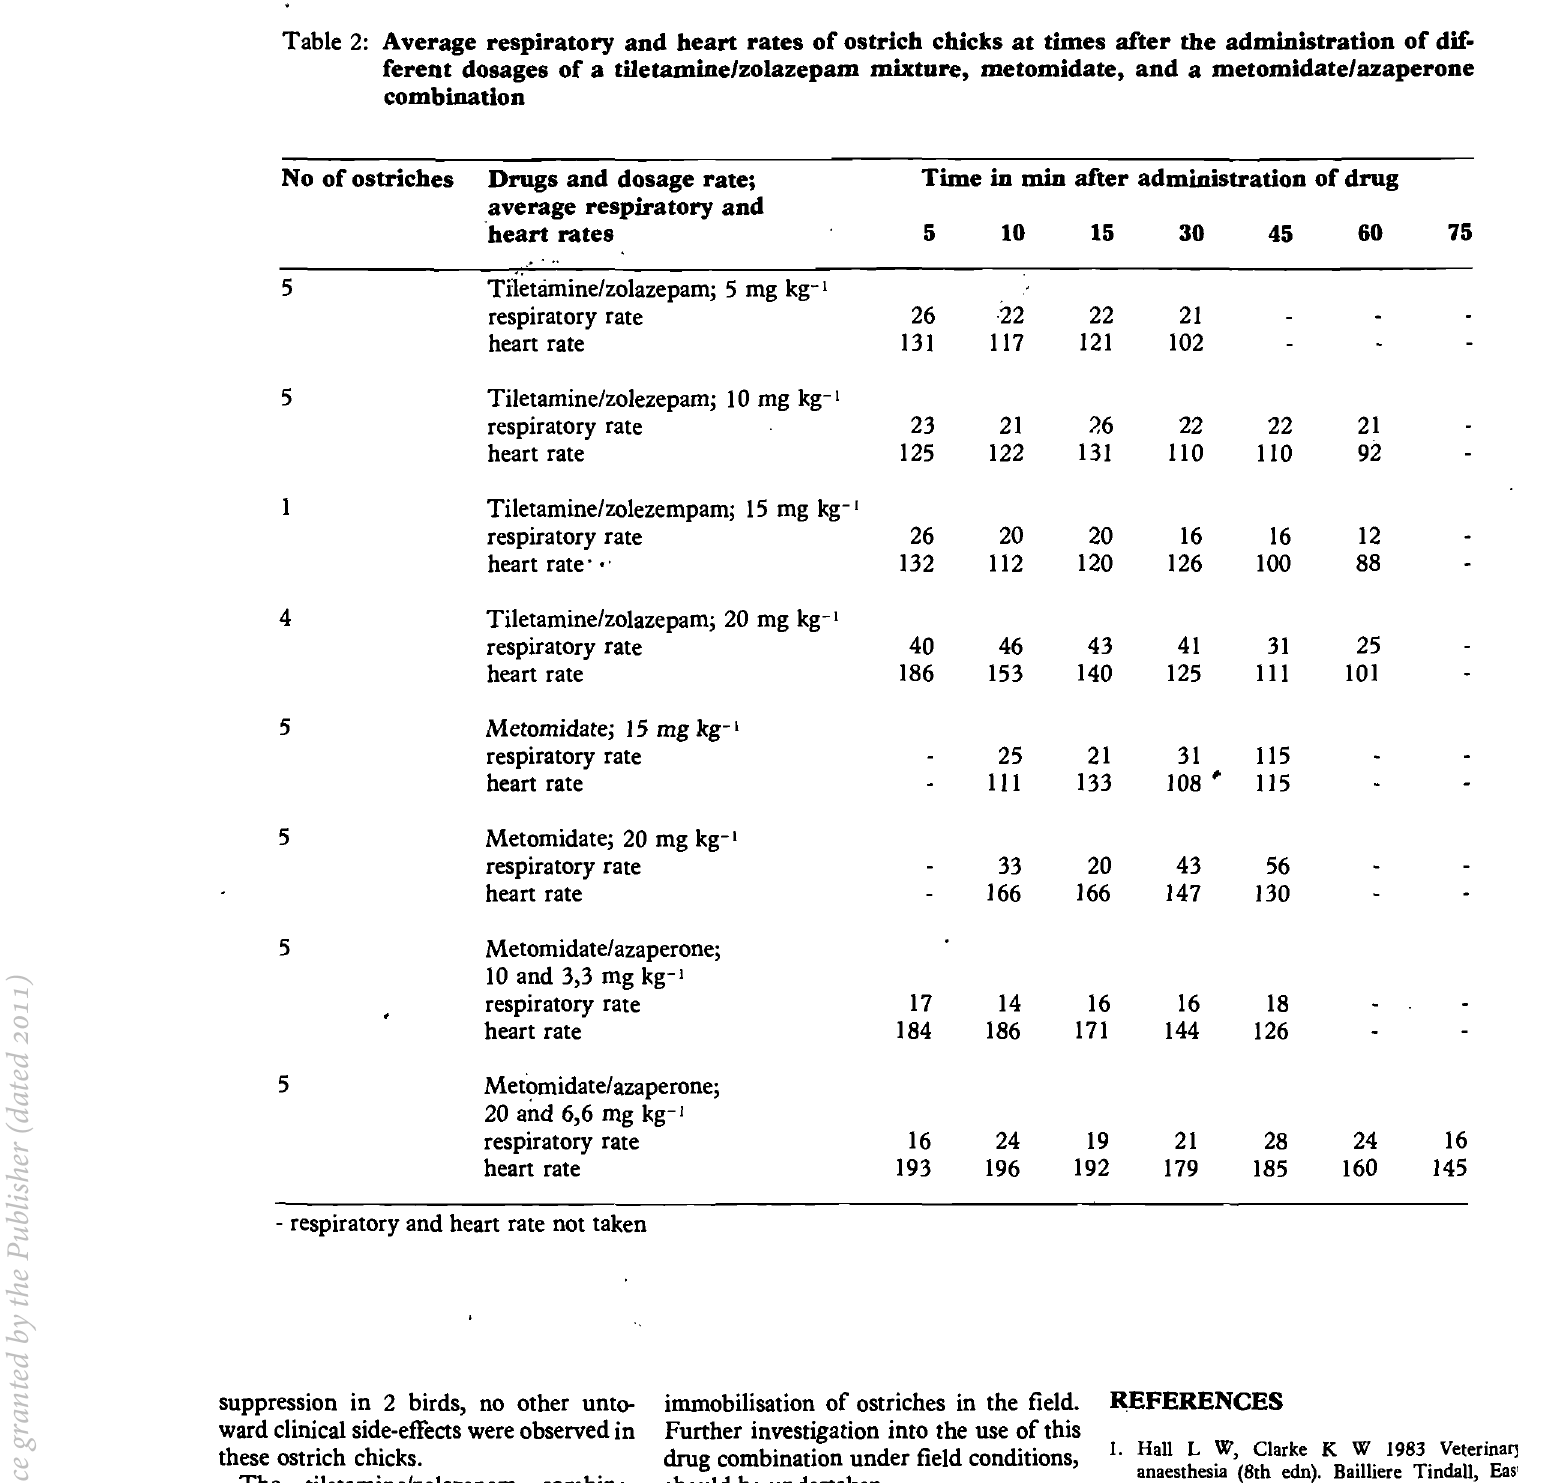
Table 2: Average respiratory and heart rates of ostrich chicks at times after the administration of dif- ferent dosages of a tiletamine/zolazepam mixture, metomidate, and a